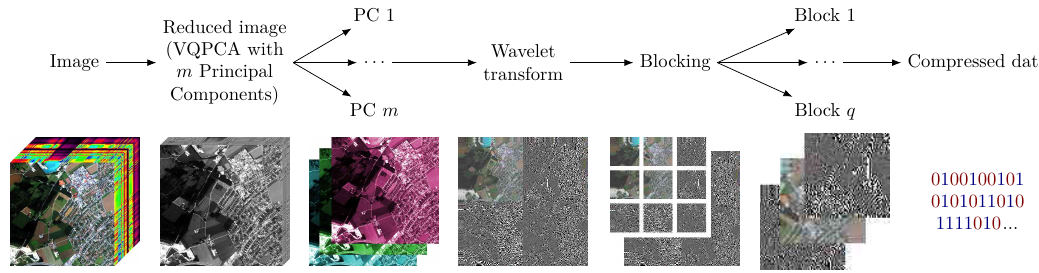
Figure 1. General flow and steps of the algorithm. Steps after separation in PCs are applied per